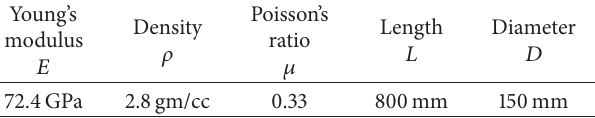
Table 5: Material properties of aluminum-alloy, 2014- 𝑇 4 .